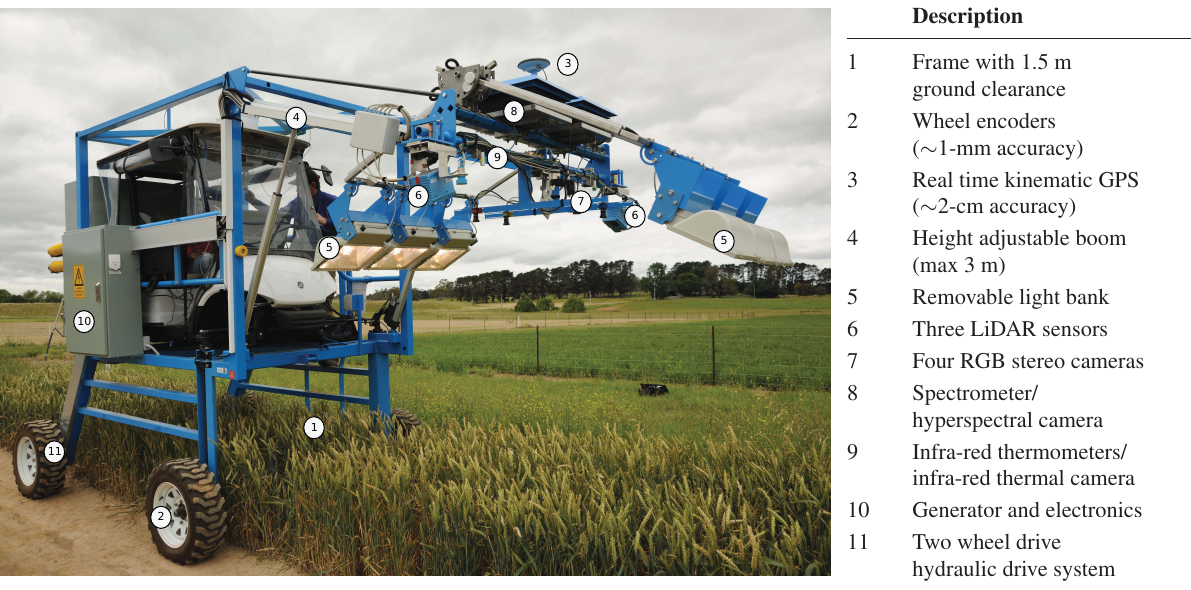
Figure 1. Components of the